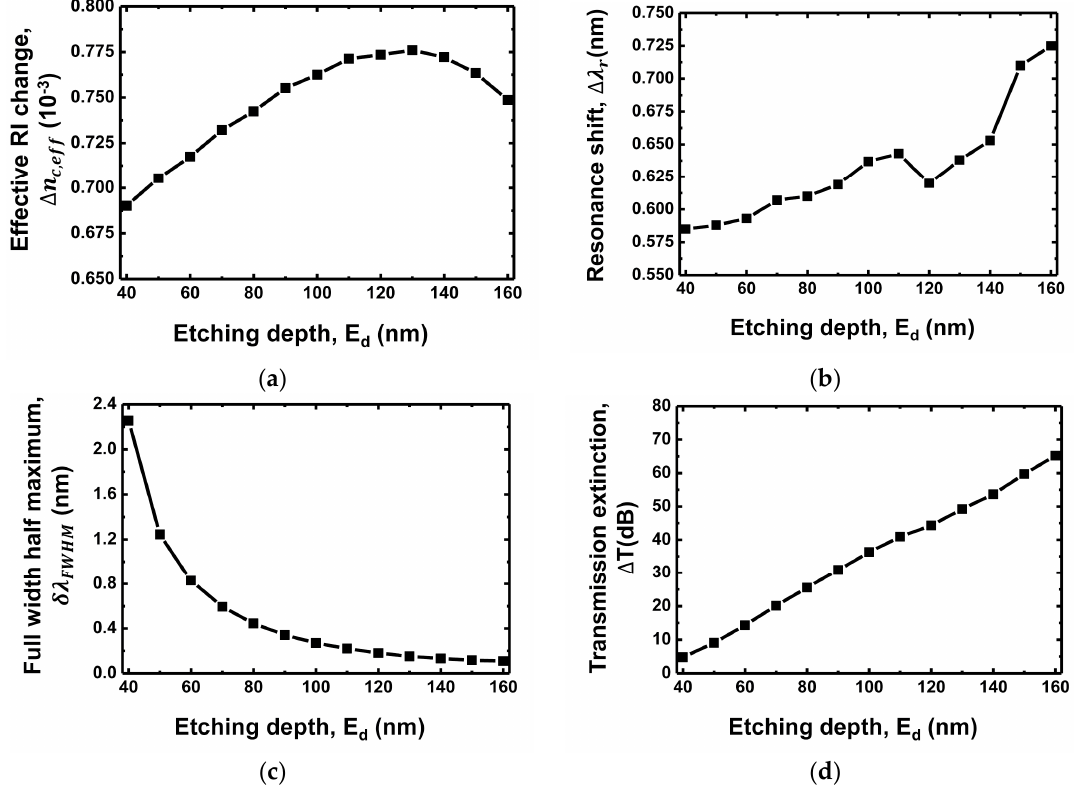
Figure 6. ( a ) Effective RI change ( ∆ n ef f ); ( b ) Resonance shift ( ∆ λ r ); ( c ) FWHM ( δλ FWHM ); ( d ) Transmission extinction ( ∆ T) as functions of the etching depth of the grating